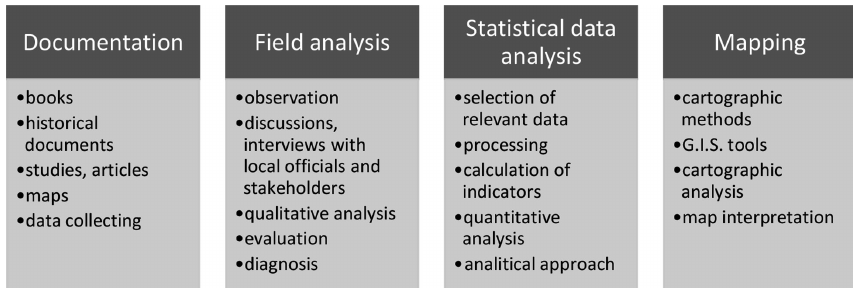
Fig. 4. A flowchart of the methodology used. Source: own